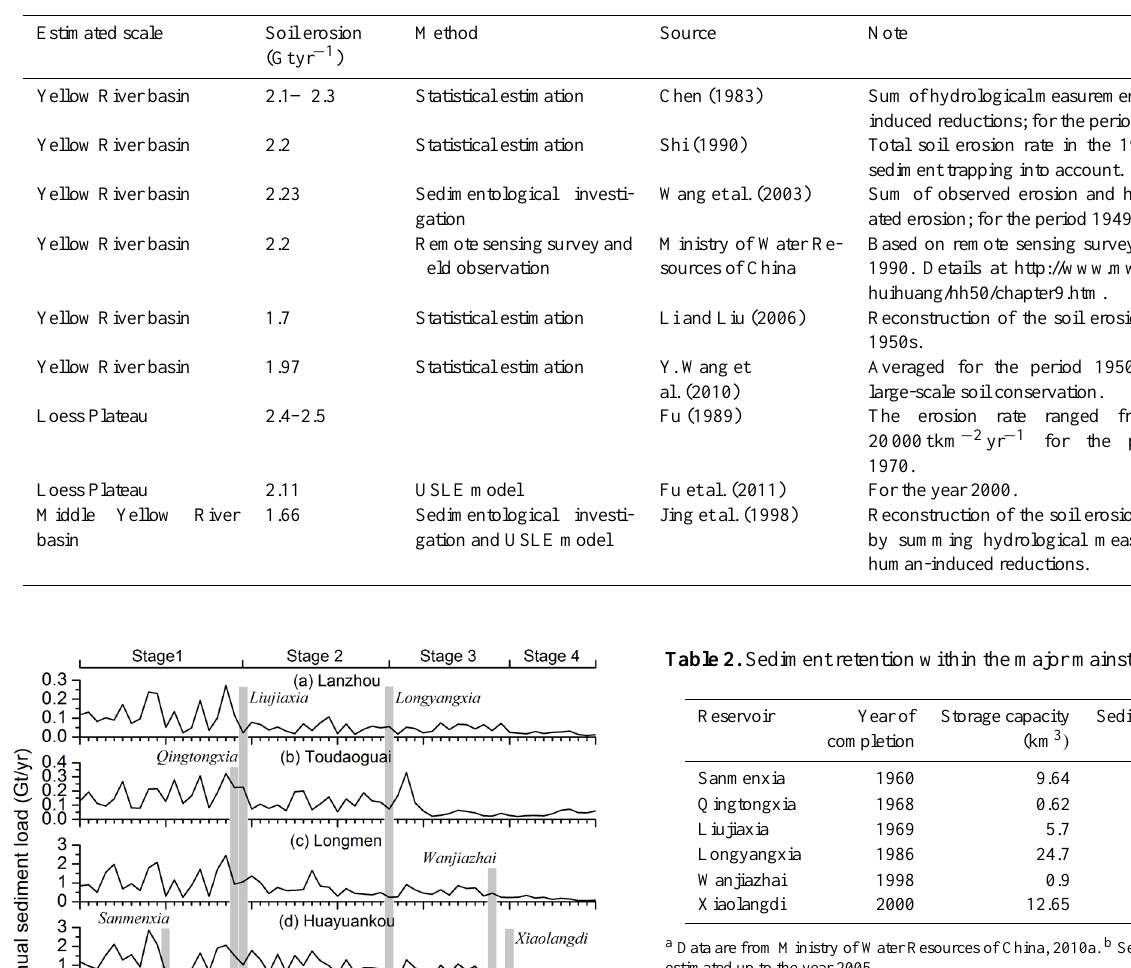
Table 1. Estimates of soil erosion rate in the Yellow River basin.